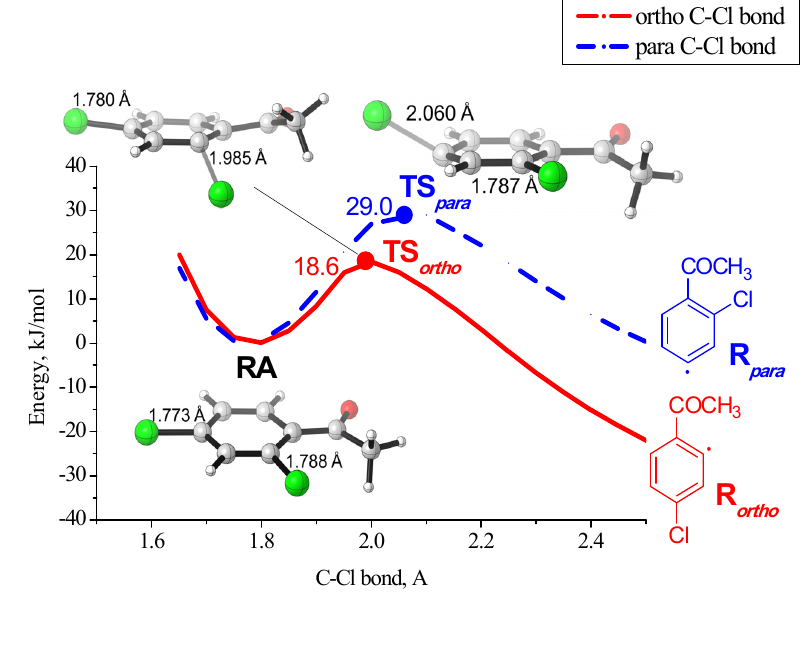
Figure 2. Relaxed potential energy diagram (employing optimised geometry at each point) for the dissociation of chlorides anions from radical anion RA of compound 12 . Structures of radical anion RA and transition states TS and TS with the C–Cl bond distances are para ortho